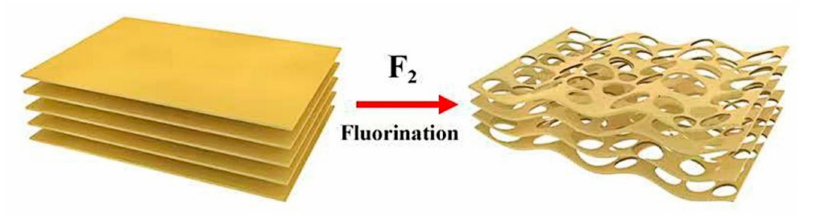
Figure 1. The schematic synthesis process of